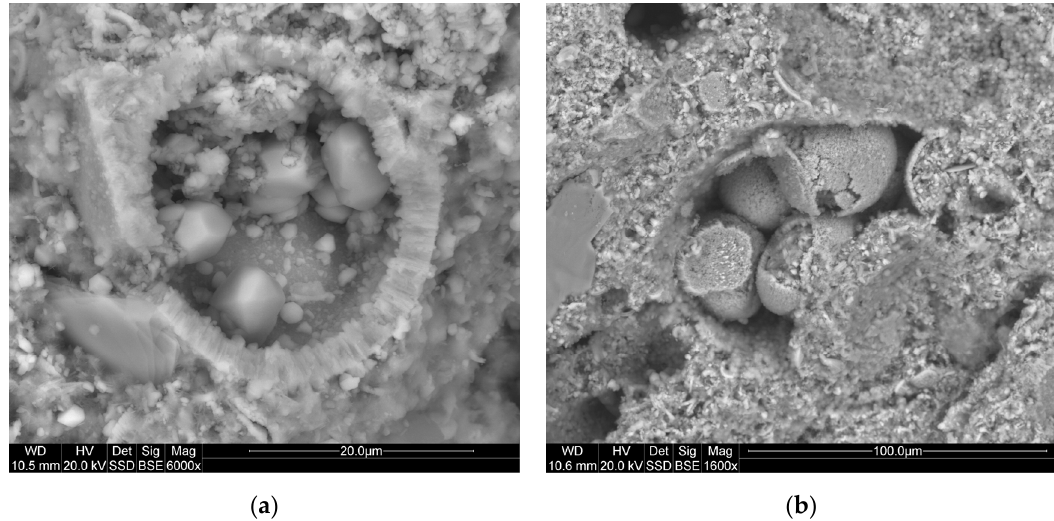
Figure 8. ( a ) Well-preserved quartz crystals in oval bioclast void; ( b ) Framboid pyrite in the voids of bioclasts. Image SEM. SEM—scanning electron microscopy.